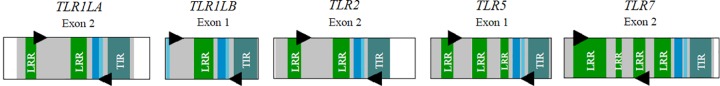
Schematic representation of the structure of the targeted TLR genes (adapted from Temperley et al., 2008; Alcaide and Edwards, 2011).Exons are represented by boxes. Arrow heads denote the position of the primers used in this study. Coloured areas designate coding regions, whereas white areas are non-coding regions. The gene regions that code for conserved domains of the protein are represented by different colours [Green, leucine-rich repeat (LRR) domains; dark blue, C-terminal LRR domains; light blue, transmembrane region; teal, cytoplasmic Toll/interleukin I resistance (TIR) domain].